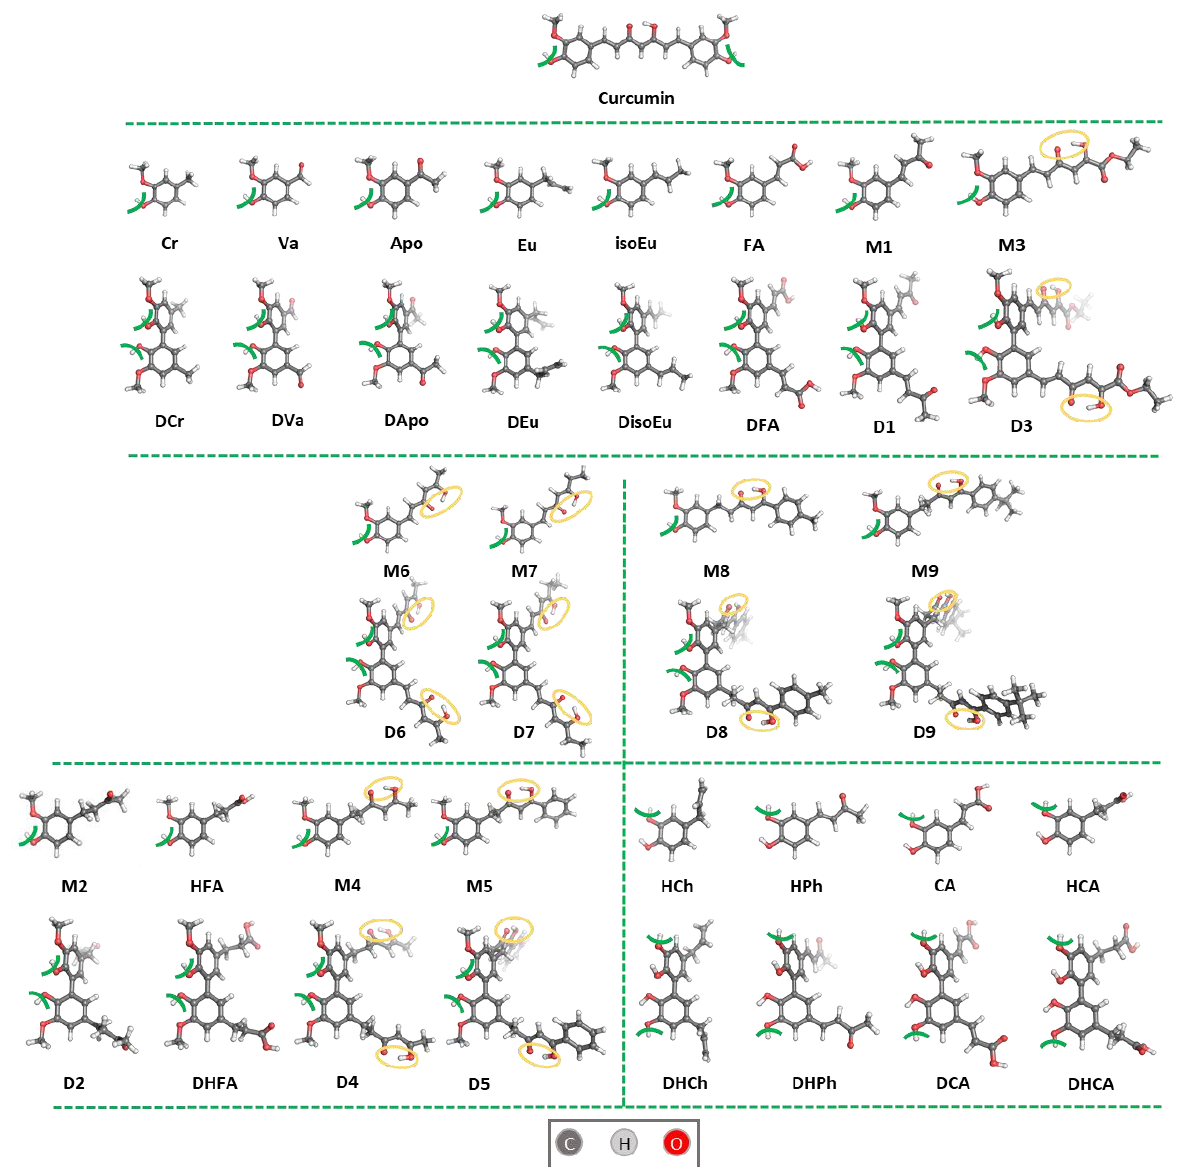
Figure 5. Optimized geometry of the most stable conformers. (Green curved line) OH groups whose BDEs are reported in Table S4 and presented in Figure 6; (yellow orange circle) structural fragment where protopropic tautomerism can occur.